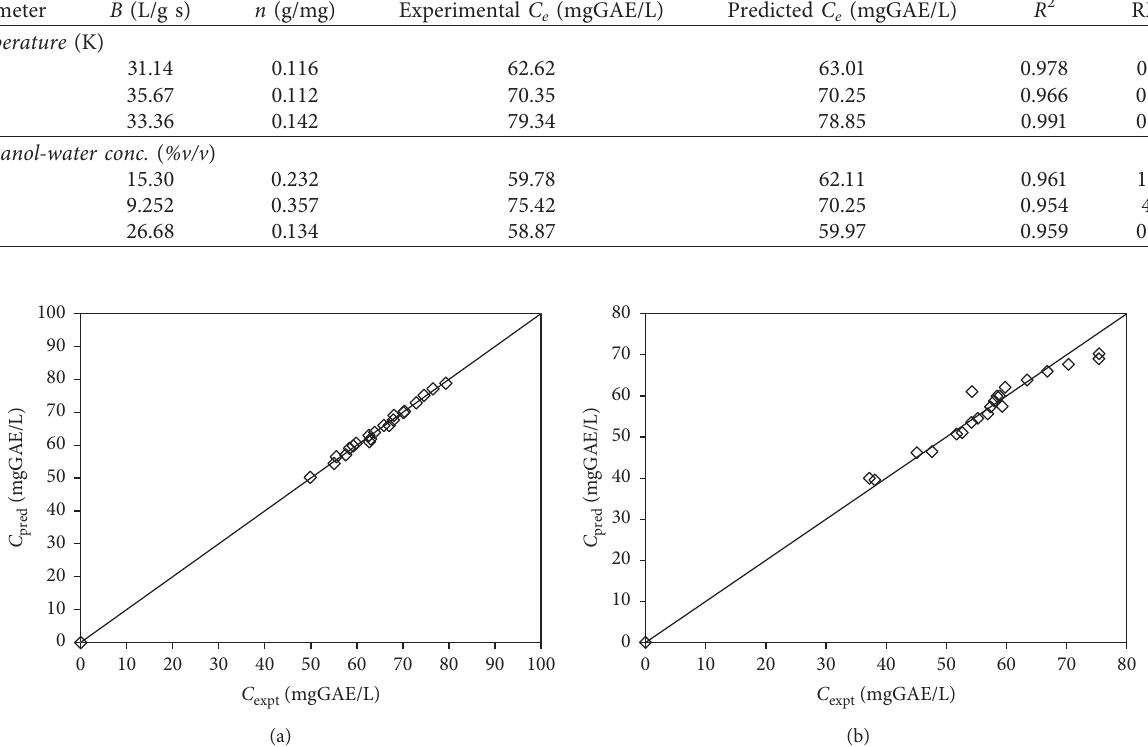
Figure 4: Correlation between experimental versus predicted values for concentrations of TPC obtained using Power law model for different temperatures (a) and solvent compositions (b).